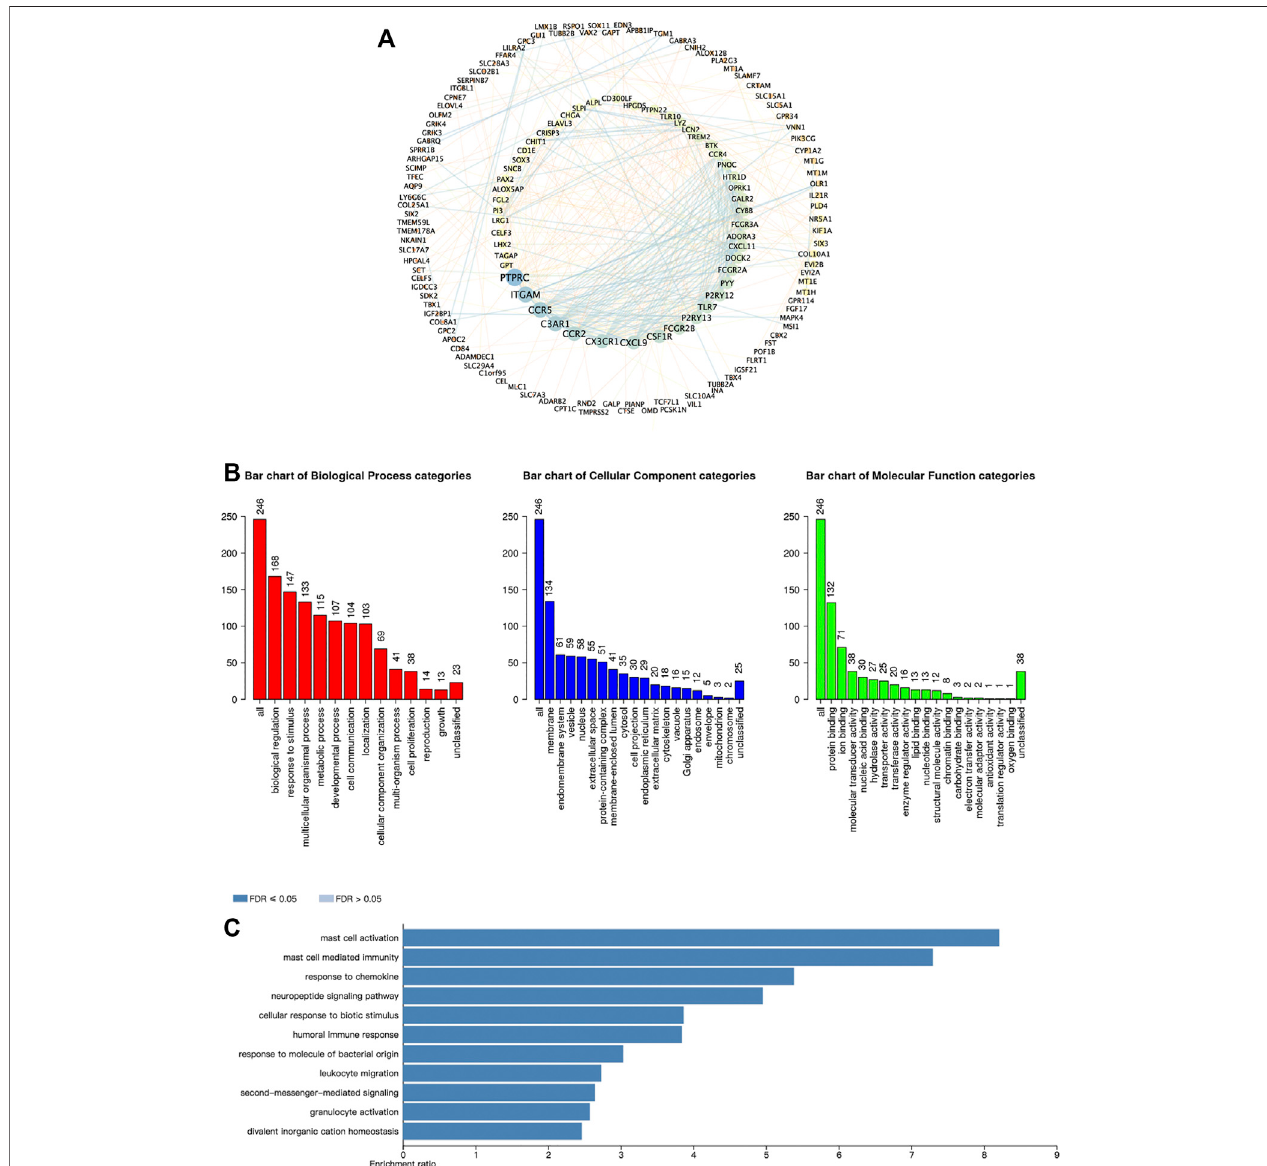
FIGURE 8 | Predicted functions and pathways of the CBXs family members and their 246 co-expressed molecules in OV. (A) PPI network of the CBXs family interaction partners was constructed (cBioPortal and Cytoscape). The colors of nodes and edges: high values to dark colors; low values to bright colors. (B) Biological process, cellular components, and molecular functions of the CBXs family interaction partners was predicted by GO functional enrichment analysis (WebGestalt). (C) KEGG pathway analysis on the CBXs family interaction partners was shown (WebGestalt).